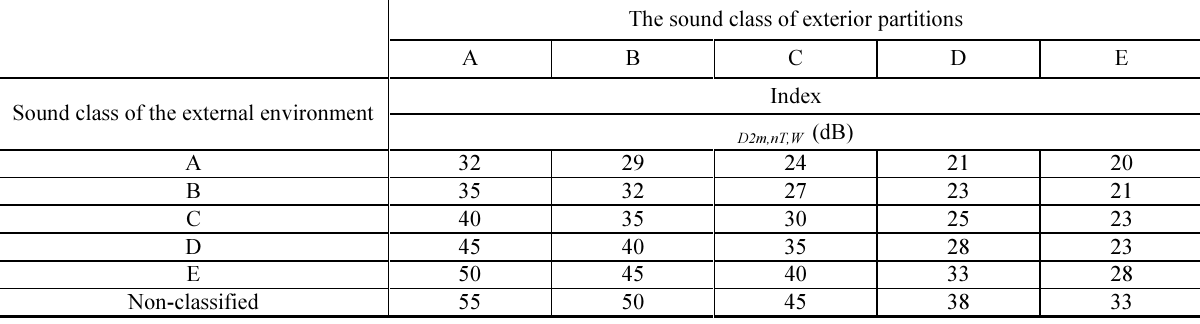
Table 1. Classification of airborne sound insulation of exterior walls. The lowest values of the standardised difference in levels index D 2m,nT,W